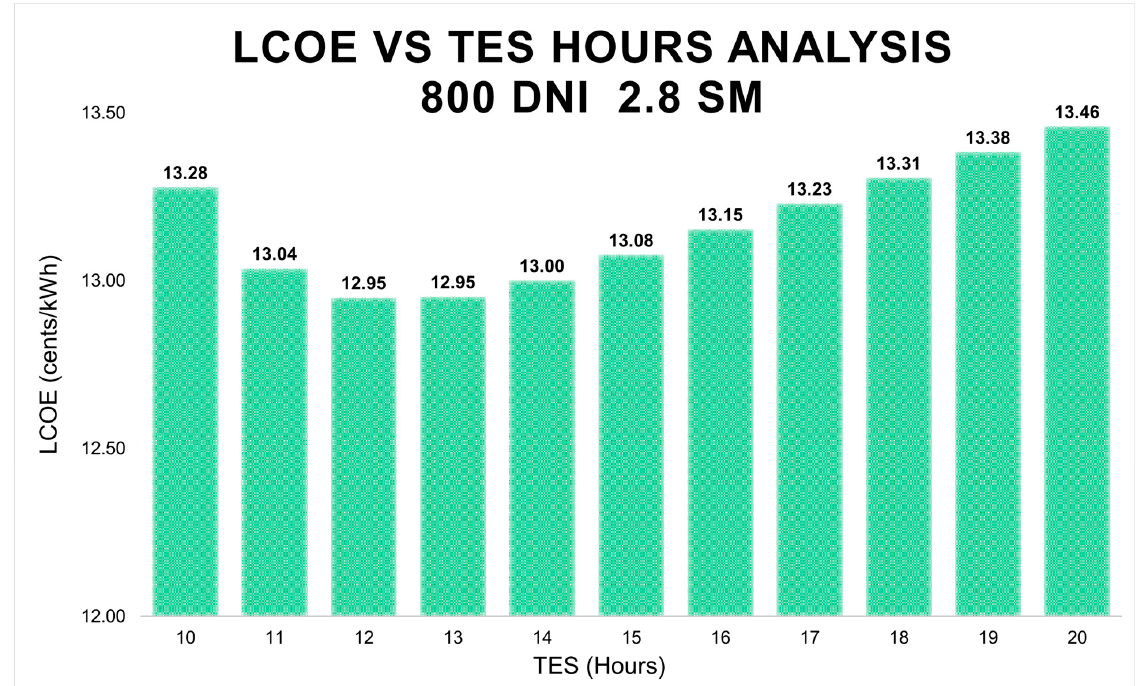
Figure 12. Optimization for 800 DNI and 2.8 SM.